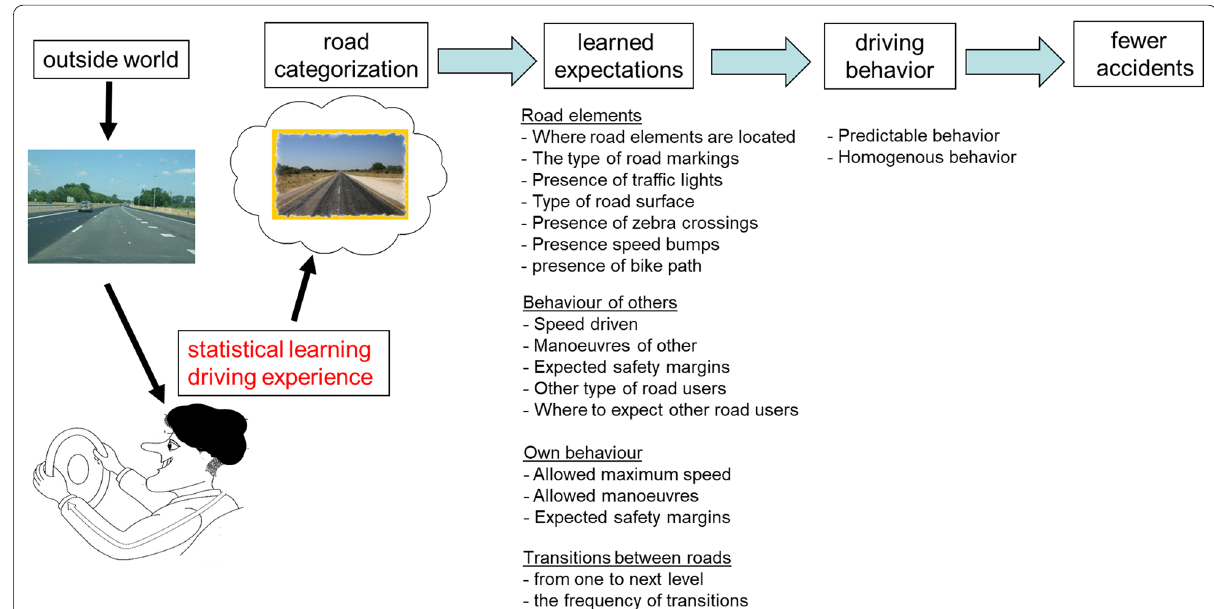
Fig. 3 A hypothetical model explaining the relationship between statistical learning and subjective road categorization and how this affects road behaviour (adapted from Theeuwes et al.